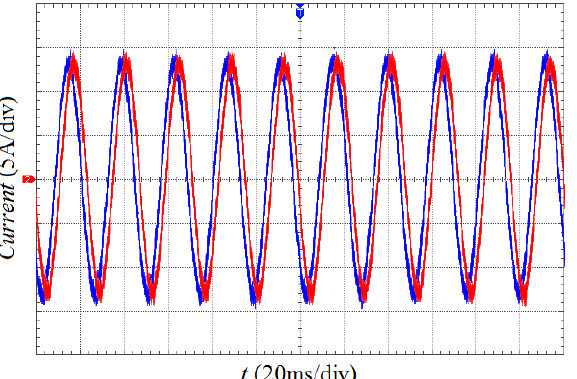
Figure 26. Experimental current waveforms of DZIPWM at m = 0.9703; current i a (blue line) and i u (red line).